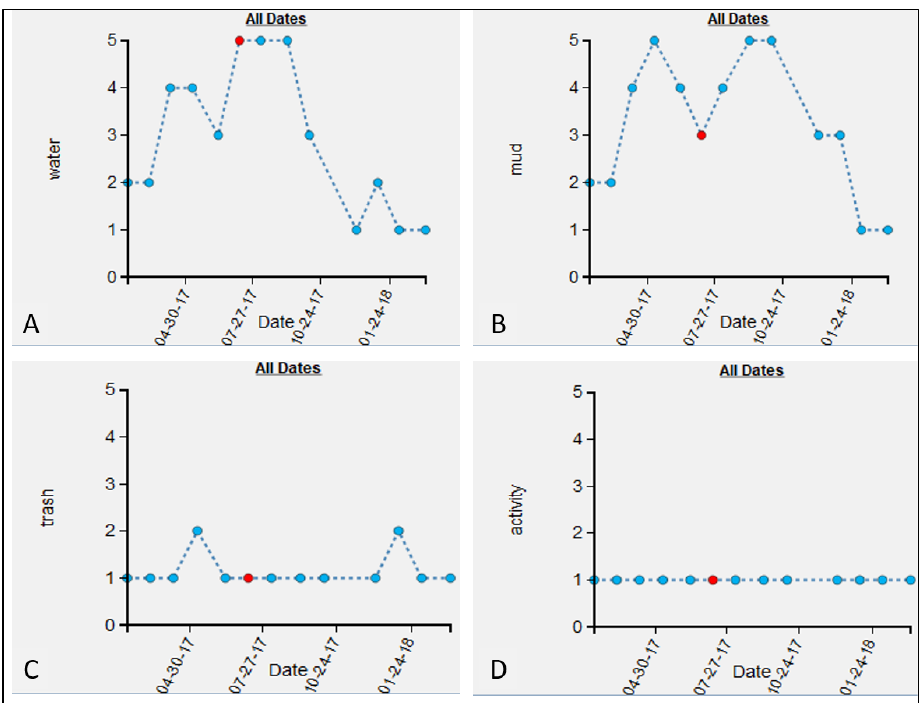
Figure 4. Environmental variable time-chart for ( A ) water, ( B ) mud, ( C ) trash, ( D ) activity. The red dot indicates the currently queried instance.